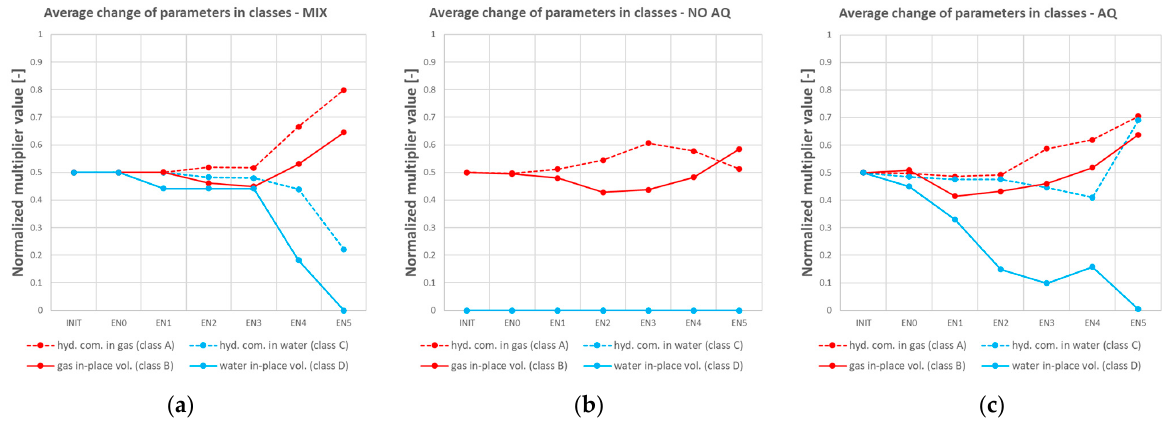
Figure 10. The average change of parameters during the history-matching, various aquifer scenarios—calibration using one year of production data. ( a ) Scenario mix; ( b ) no aquifer; ( c ) aquifer.